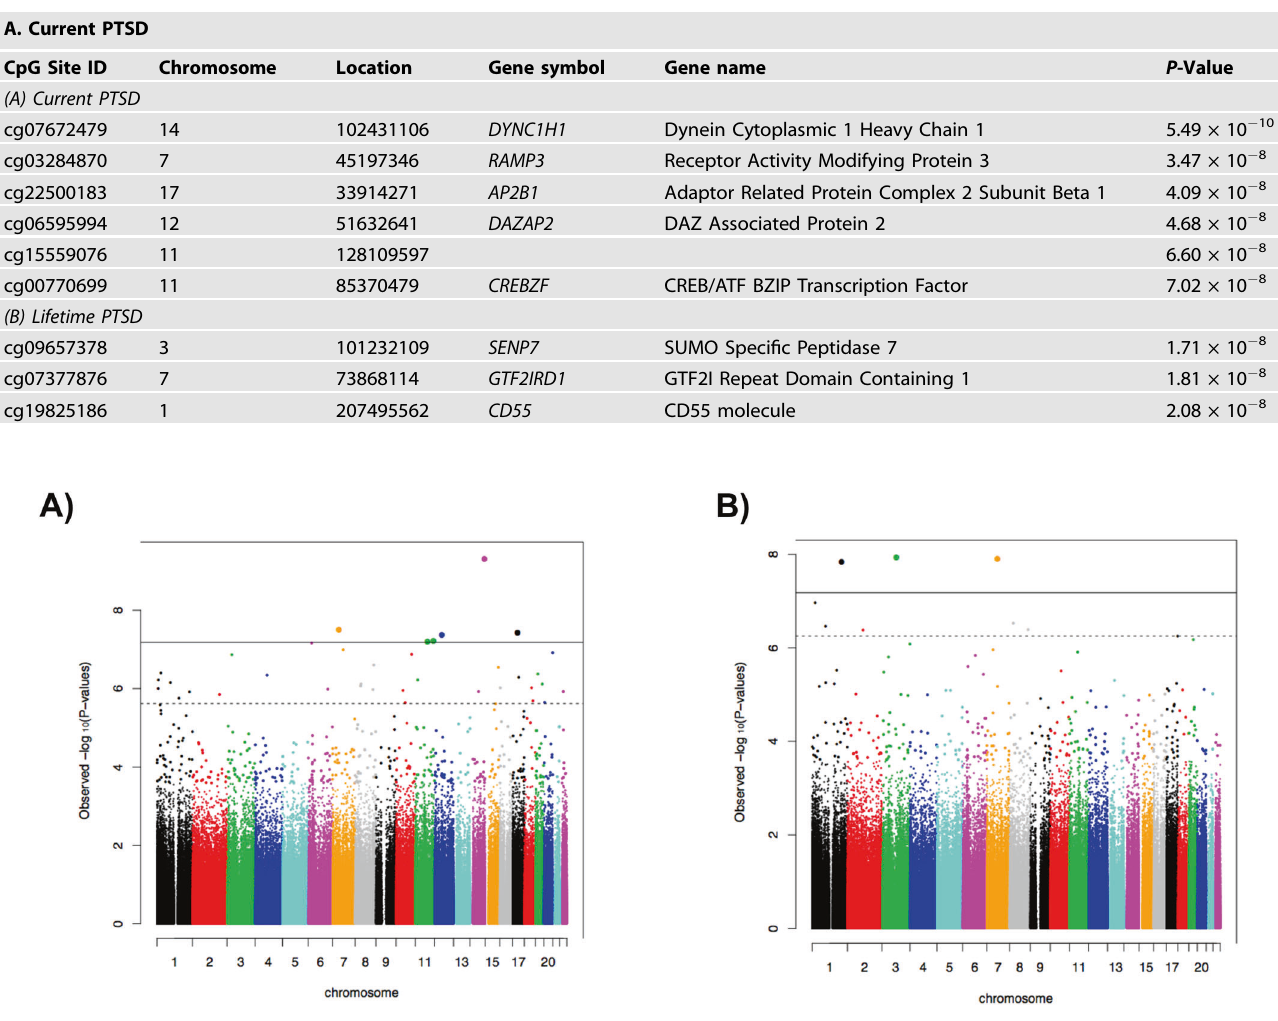
Table 3. Genome-wide signi fi cant DNA methylation sites associated with PTSD in U.S. veterans.